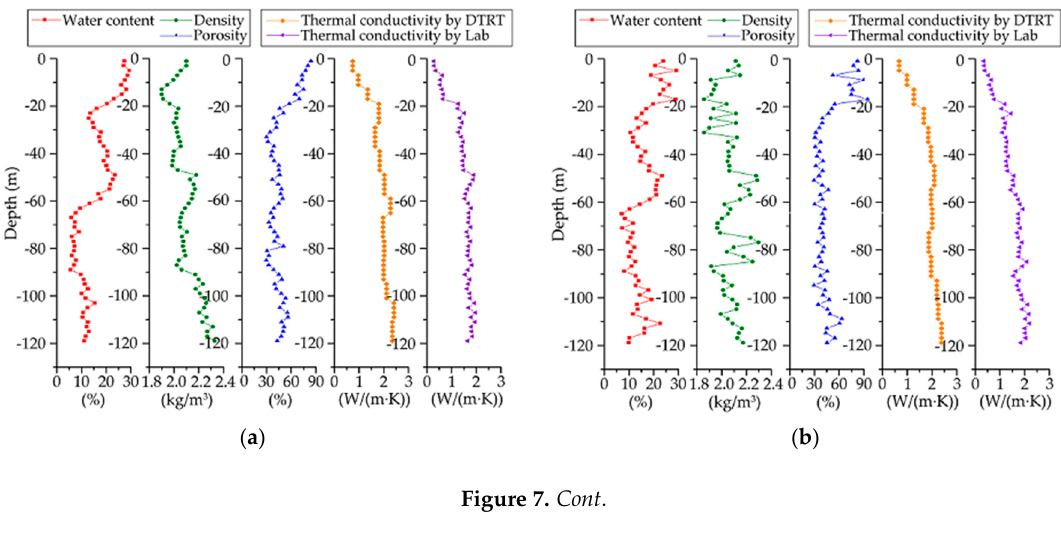
Figure 6. Temperature profile recorded during the heating process in the borehole by the DTRT.